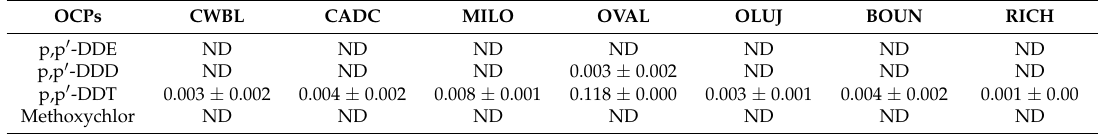
Table 3. Mean concentration (mg/kg) of dichlorodiphenylethene in the cocoa beverages. OCPs CWBL CADC MILO OVAL OLUJ BOUN RICH p,p (cid:48) -DDE ND ND ND ND ND ND ND p,p (cid:48) -DDD ND ND ND 0.003 ± 0.002 ND ND ND p,p (cid:48) -DDT 0.003 ± 0.002